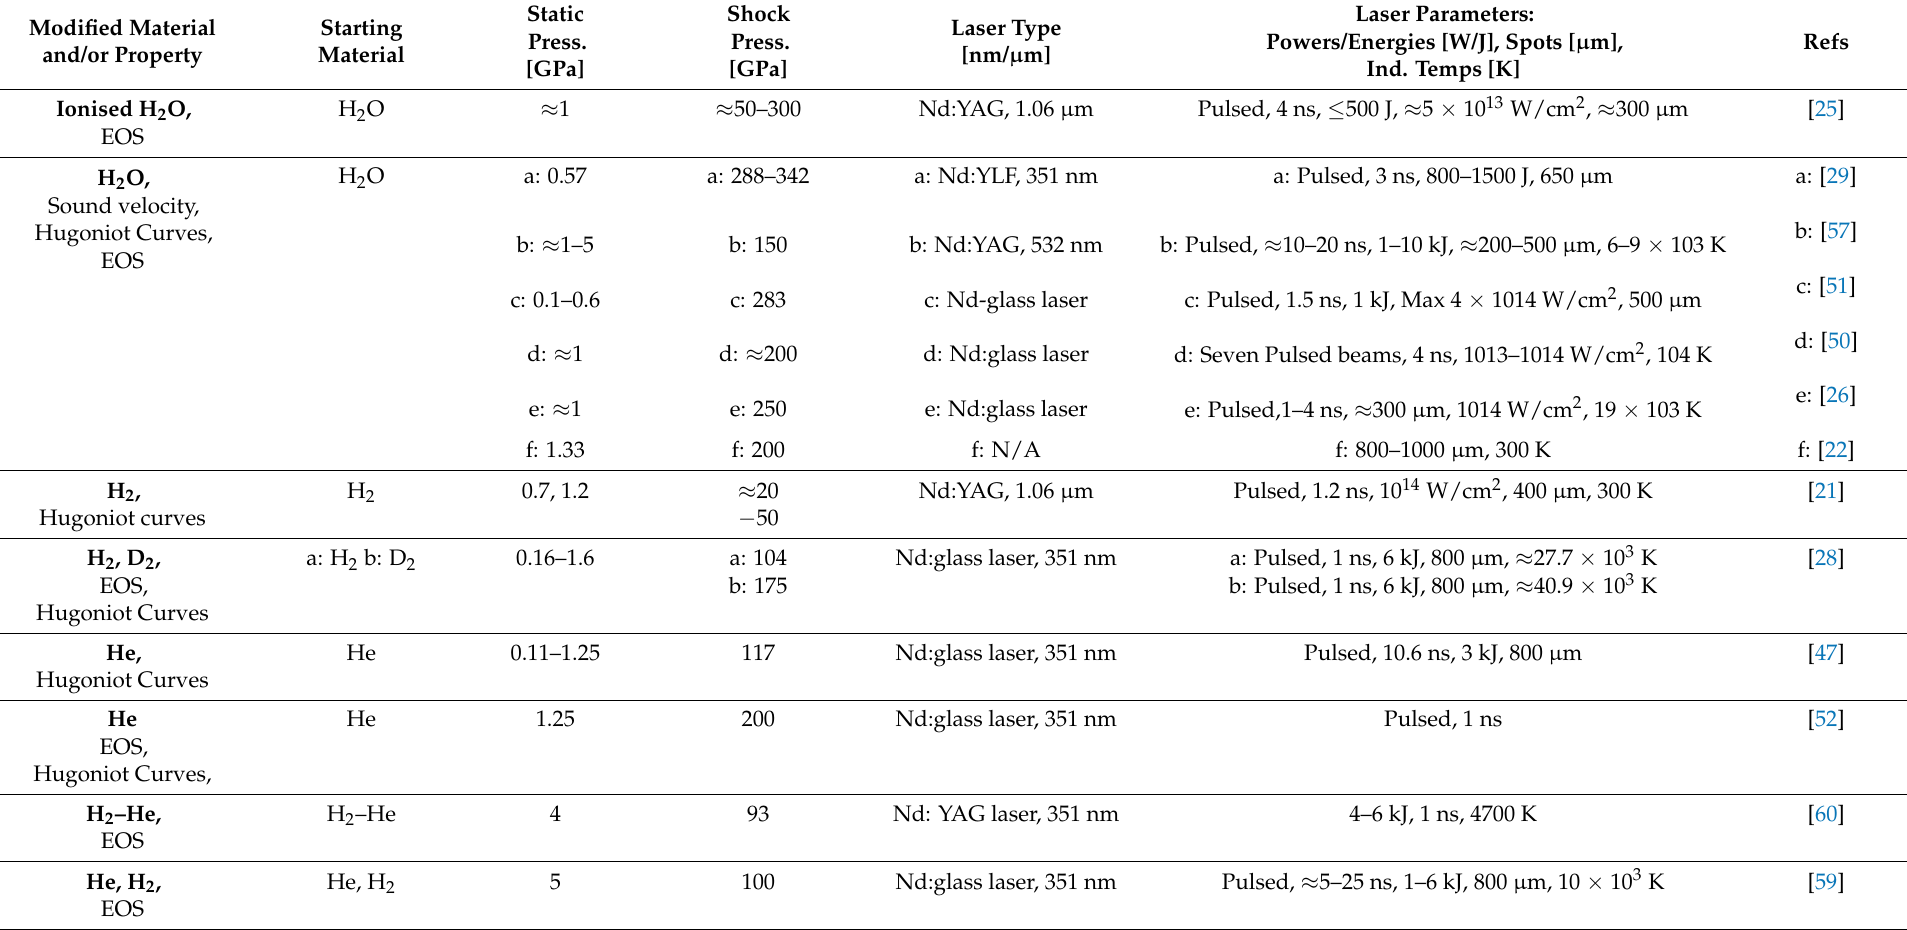
Table 1. (H, He)-Based, Low-Z Fluids studied/modified in selected LDC–DAC